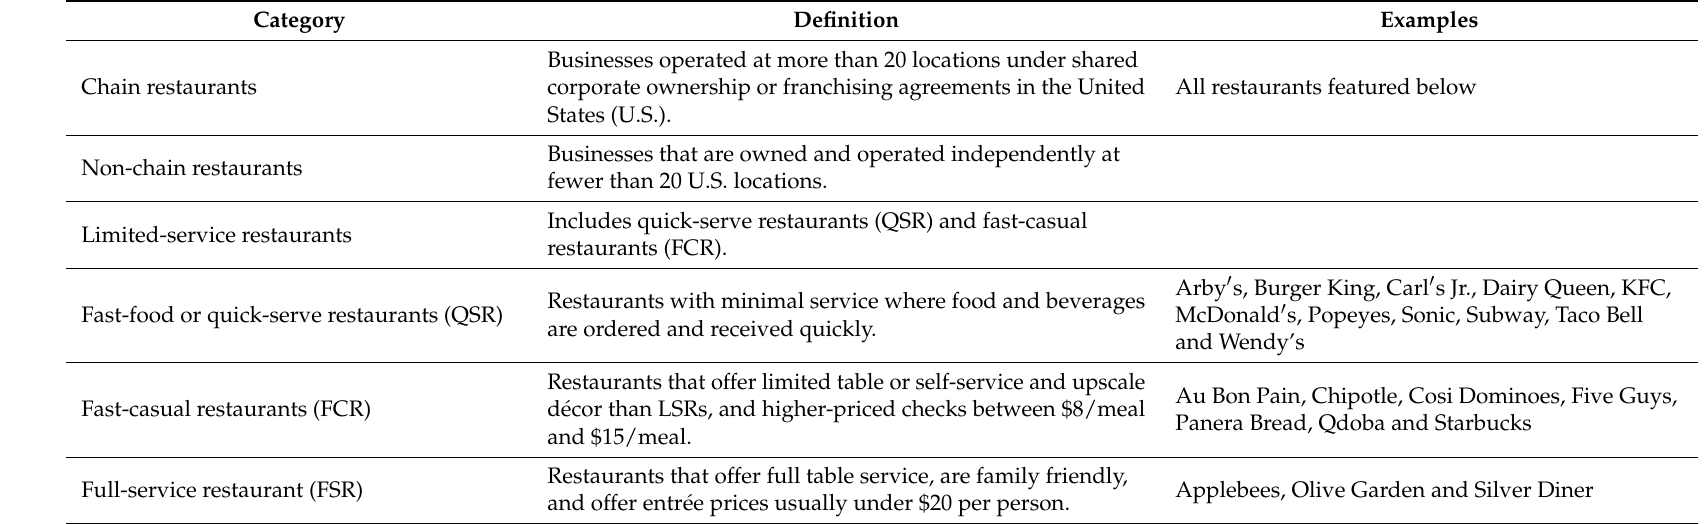
Table 3. U.S. restaurant categories, definitions and